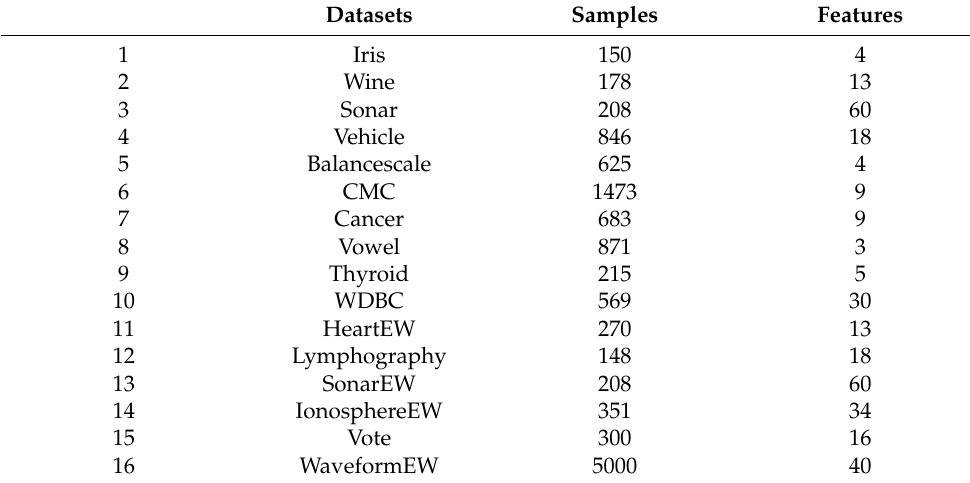
Table 1. The datasets used in the